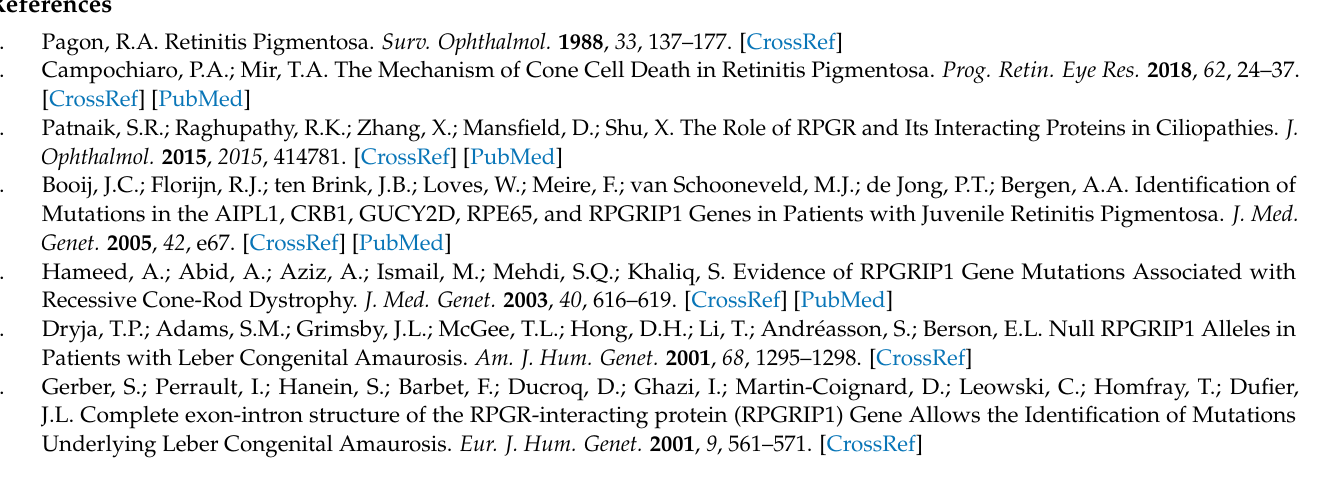
targets. Table S1: Primers used for qRT-PCR; Table S2: Sources used for targets or genes screening; Table S3: Main active components of Gynostemmae pentaphylli ; Table S4: Topological network analysis of common targets among gypenosides, inflammation and retinitis pigmentosa;Table S5: Topological network analysis of common targets among gypenosides, oxidative stress and retinitis pigmentosa; Table S6: Gene ontology (GO) enrichment analysis of common targets among gypenosides, inflamma- tion, oxidative stress and retinitis pigmentosa; Table S7: Kyoto Encyclopedia of Genes and Genomes (KEGG) enrichment analysis of common targets among gypenosides, inflammation, oxidative stress and retinitis